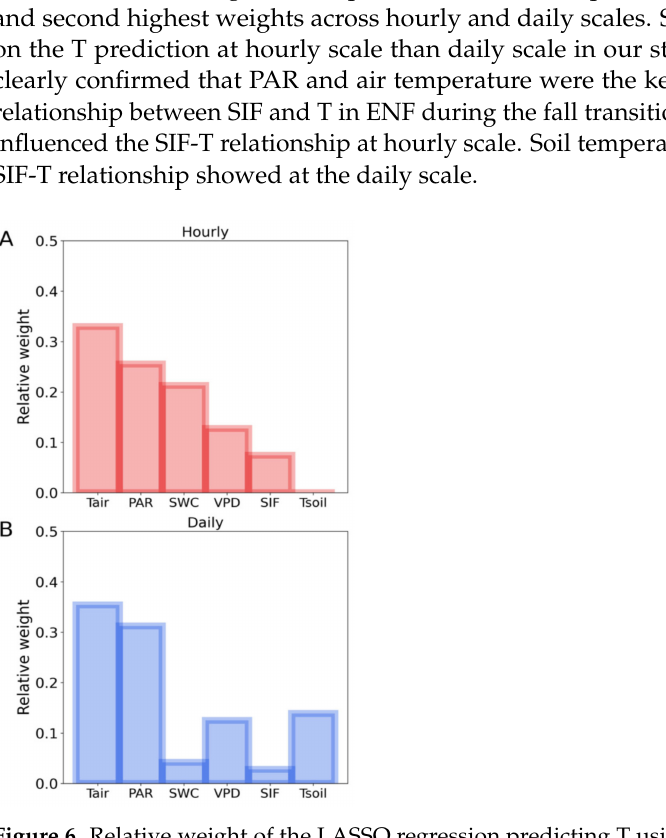
Figure 6. Relative weight of the LASSO regression predicting T using PAR, air temperature (Tair), VPD, soil temperature (Tsoil), soil water content (SWC) and SIF as input variables at hourly ( A ) and daily scales ( B